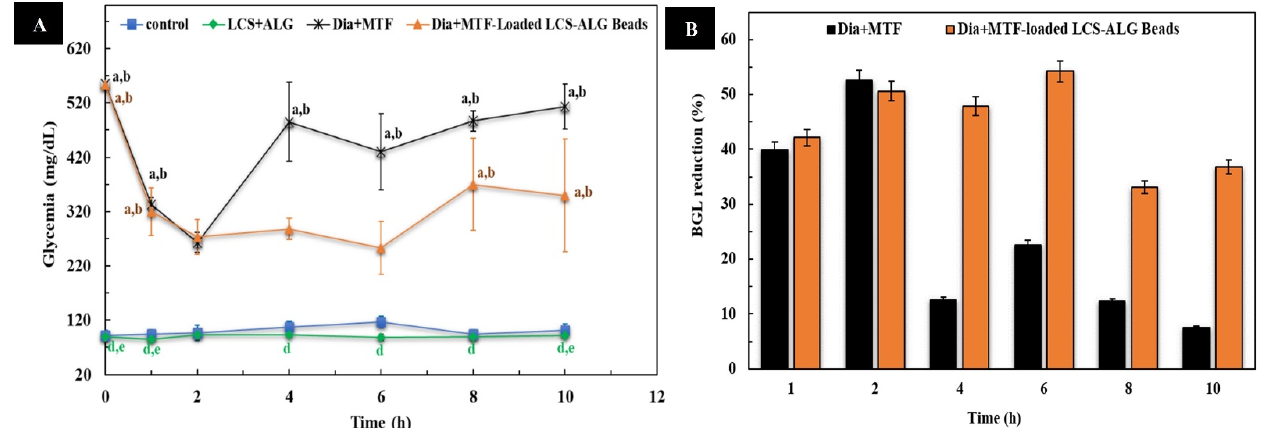
Figure 10. ( A ) Changes in blood glucose level (BGL) over 10 h on Day 1 of the experiment. Data are presented as (mean ± SE, n = 6), significance at p < 0.05. a: significantly different when compared to control, b: significantly different when compared to LCS + ALG, d: significantly different when compared to Dia + MTF and e: significantly different when compared to MTF-Loaded LCS-ALG bead group. ( B ) Percentage of reduction in BGLs of Dia +MTF and Dia + MTF-loaded LCS-ALG bead groups over 10 h.